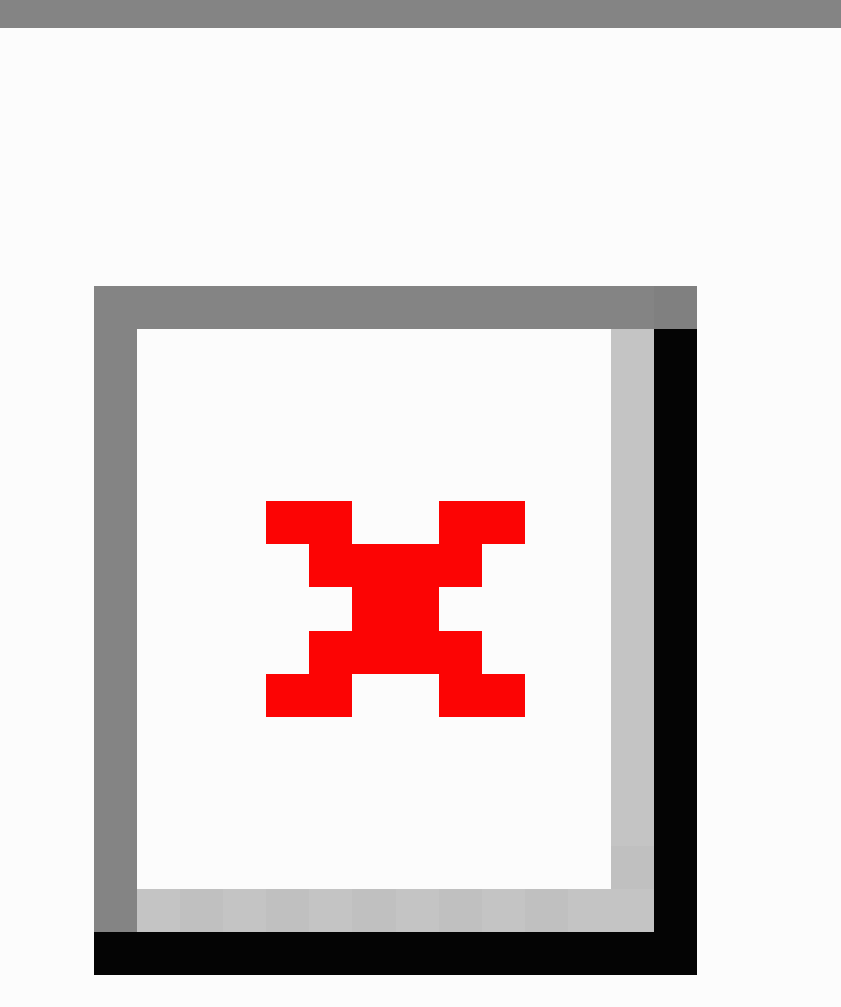
Figure 1. Reasons for using computerized systems in clinics. x-axis: 1=Offer more efficient service; 2=Ability to share patient information in public sector; 3=Reduce medical errors; 4=Eliminate need to store paper records; 5=Eliminate illegibility of my practice partners;